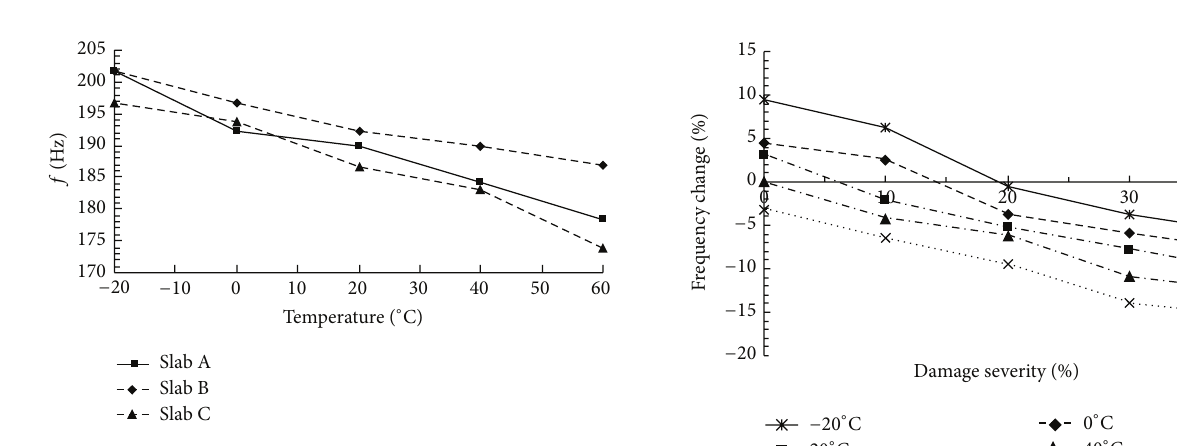
Figure 12: Temperature effect on first order natural frequency.